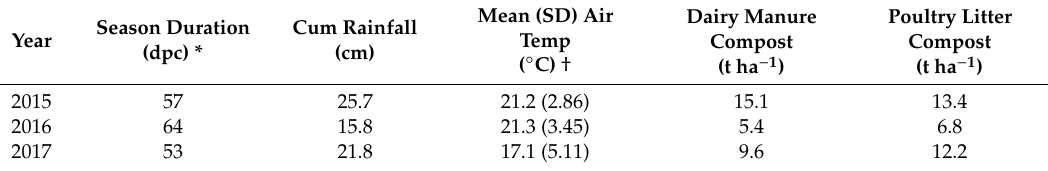
Table 2. Site conditions / rainfall is cumulative for the duration of the